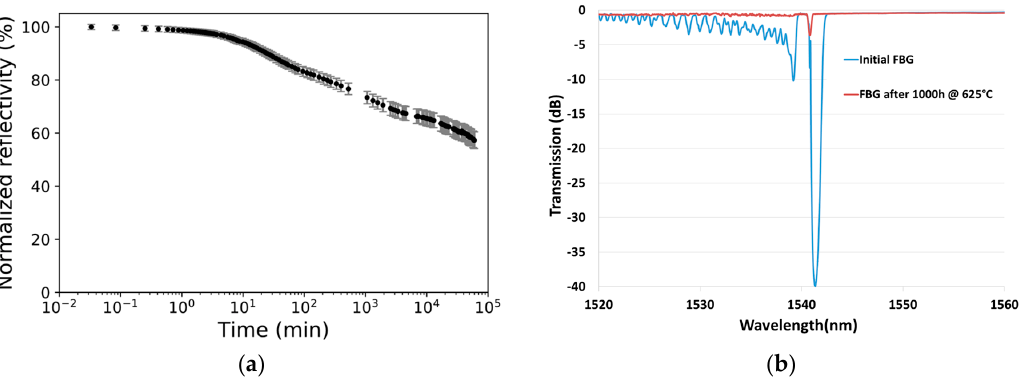
Figure 5. ( a ) Normalized refractive index change to initial strength of a type I FBG at 625 °C for 1000 h in a pure silica core fiber (Fibercore SM1500SC(9/125)P); and ( b ) its initial and final transmission spectrum.